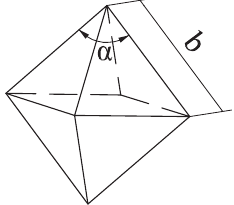
Figure 2. Illustration of the single-diamond